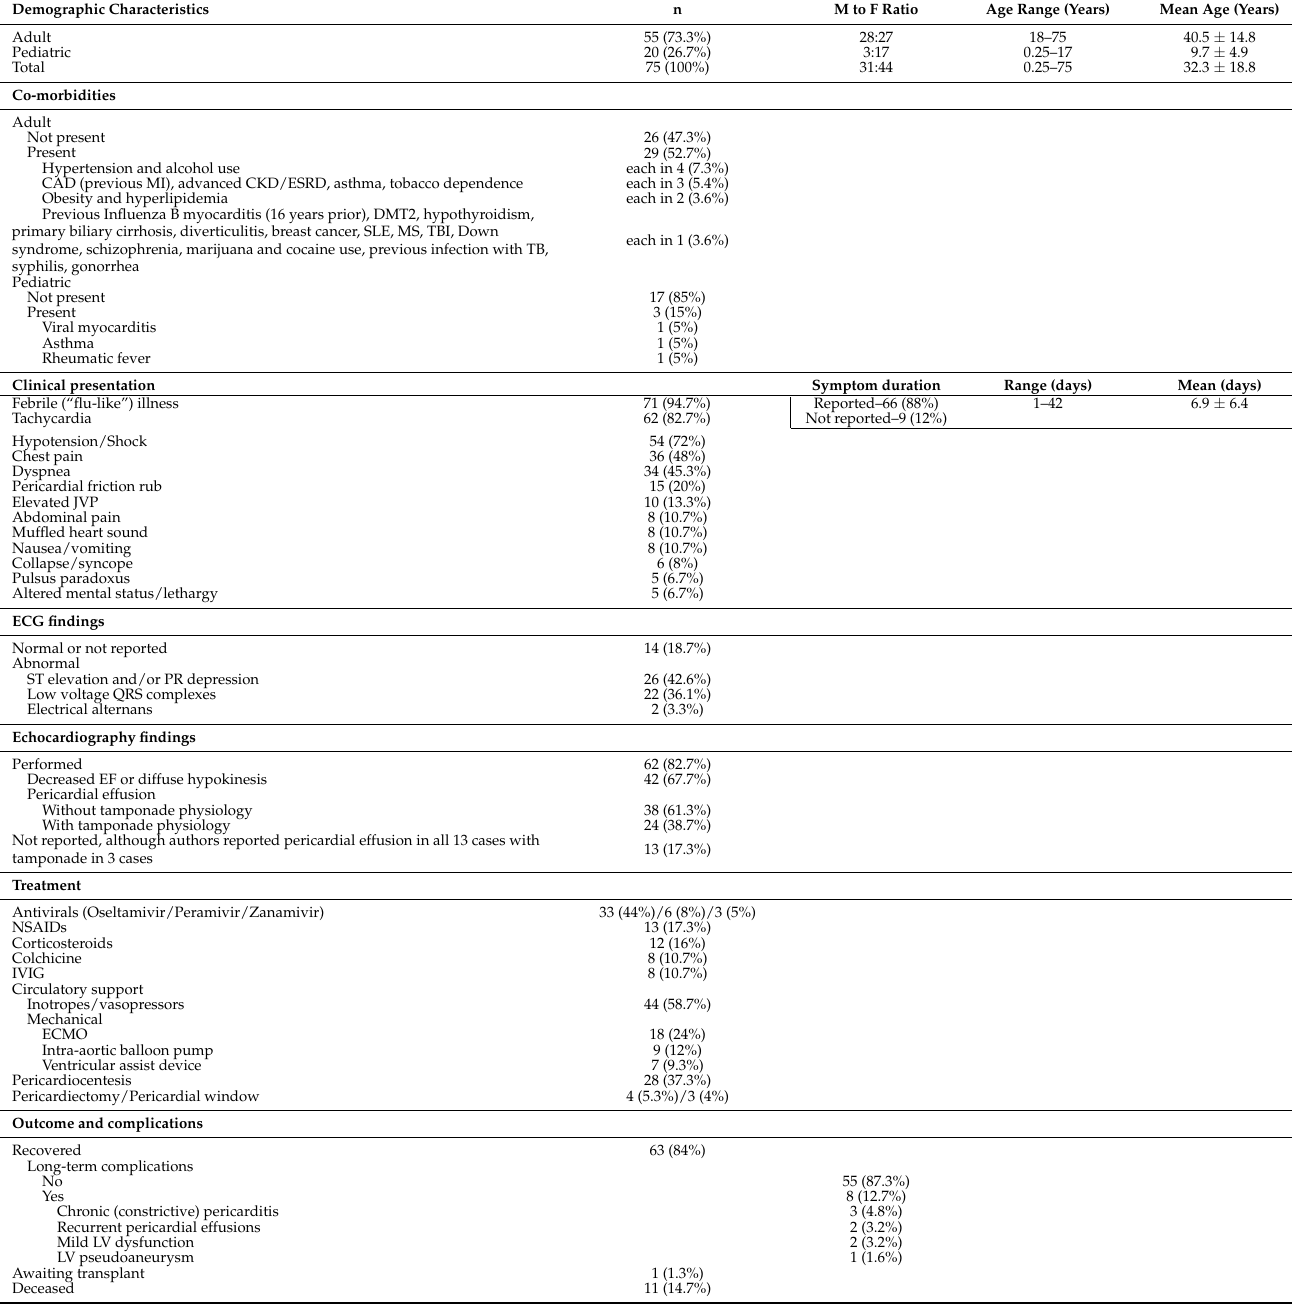
Table 1. The epidemiology, demographics, clinical presentation, diagnostic findings, and outcome of influenza myopericarditis